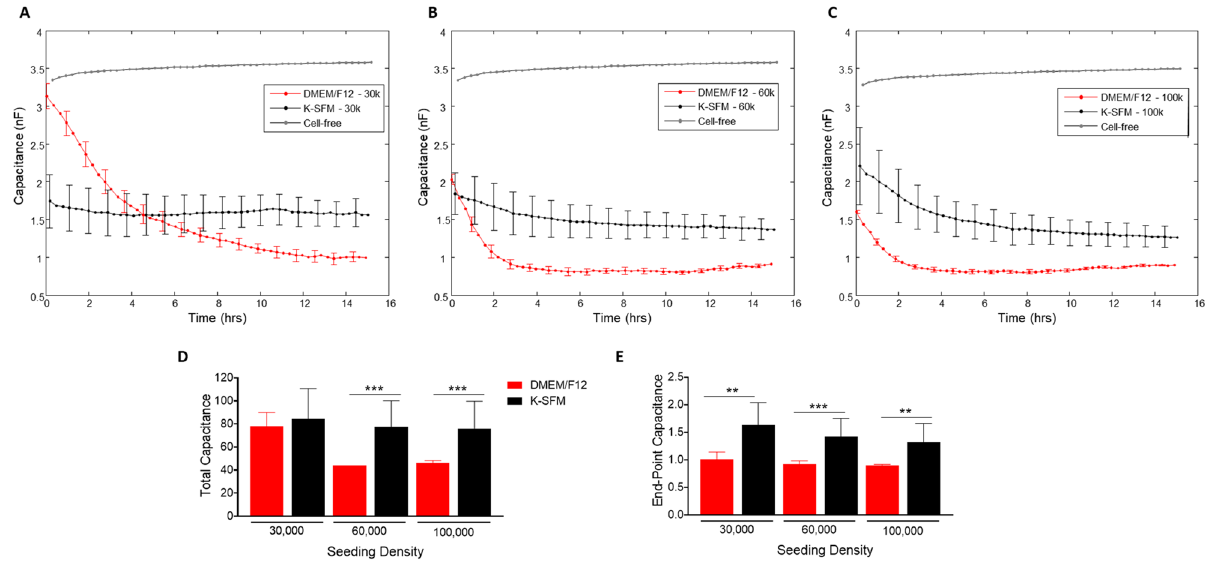
Figure 5. Real-time monitoring of HUCL capacitance in DMEM/F12 versus K-SFM media. Capacitance of HUCLs versus time, measured at an AC frequency of 64 kHz is shown for 30,000 ( A ), 60,000 ( B ), and 100,000 ( C ) cell seeding density. Total capacitance ( D ) and end-point capacitance ( E ) comparing DMEM/F12 versus K-SFM are represented by bar graphs. Data shown are the mean ± SEM; n = 5/group. ** p ≤ 0.01 and *** p ≤